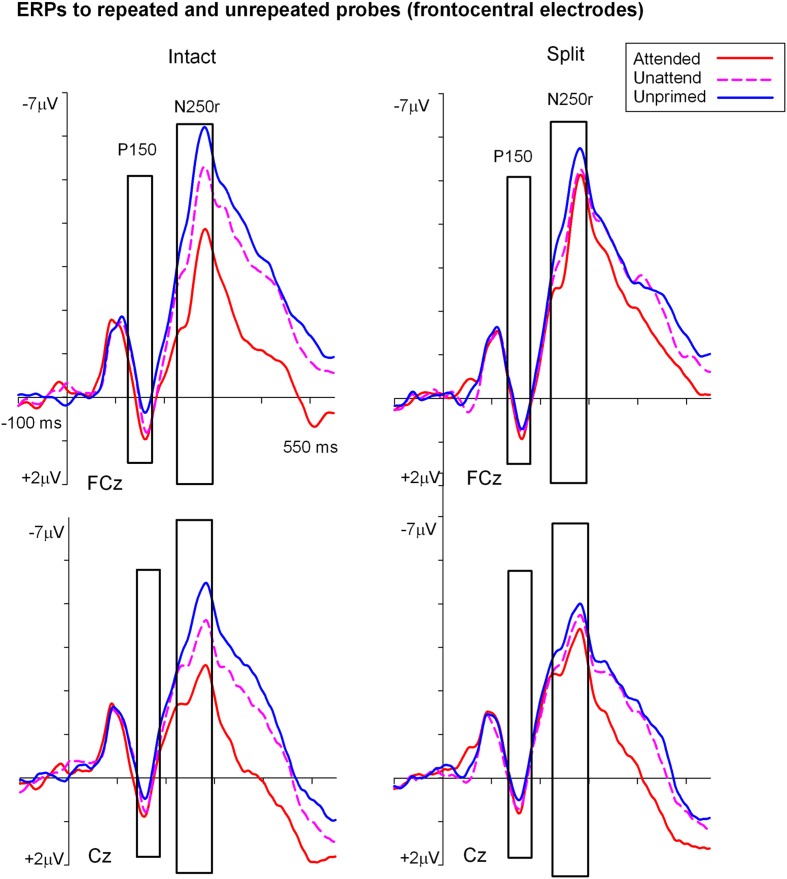
Grand-average event related potentials elicited at FCz and Cz in the time interval beginning -100 to 550 ms following the onset of (S2) probe objects as a function of the preceding split or intact (S1) prime trial type. ERPs during the P150 (140–180 ms) were the focus of statistical analyses and are shown highlighted.